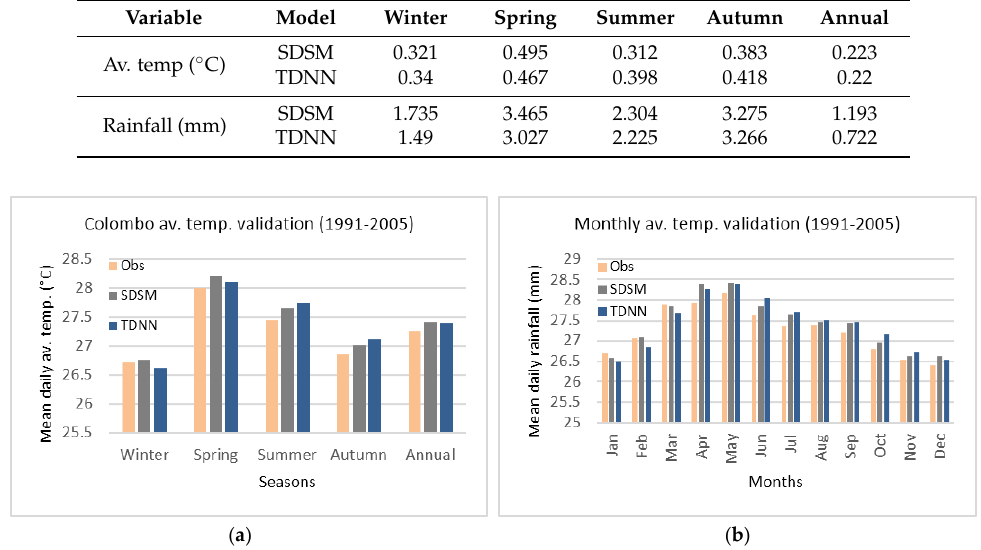
Table 3. Seasonal and annual RMSE for SDSM and TDNN.